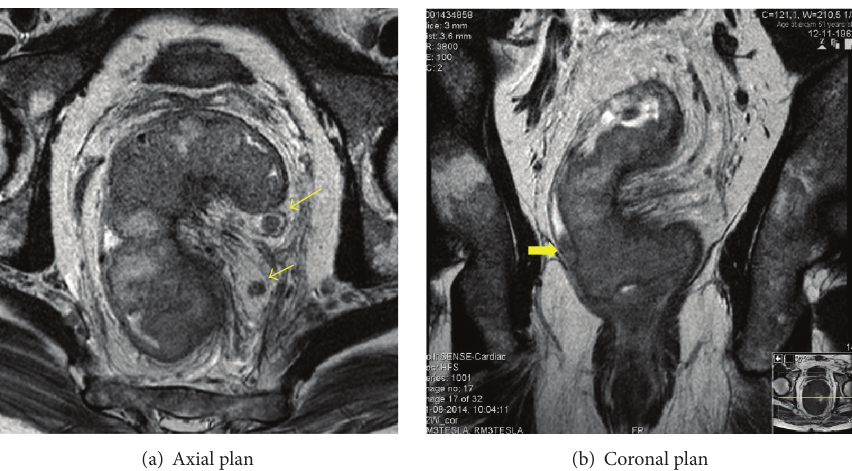
Figure2:MRIbeforeCRT.Largetumorwith9cmoflongitudinallengthand7 cmoftransversediameterthatextendstoleftsideofmesorectal fascia, multiple enlarged pelvic lymph nodes. Thin arrow: metastatic lymph node; thick arrow: mesorectal fascia invasion.